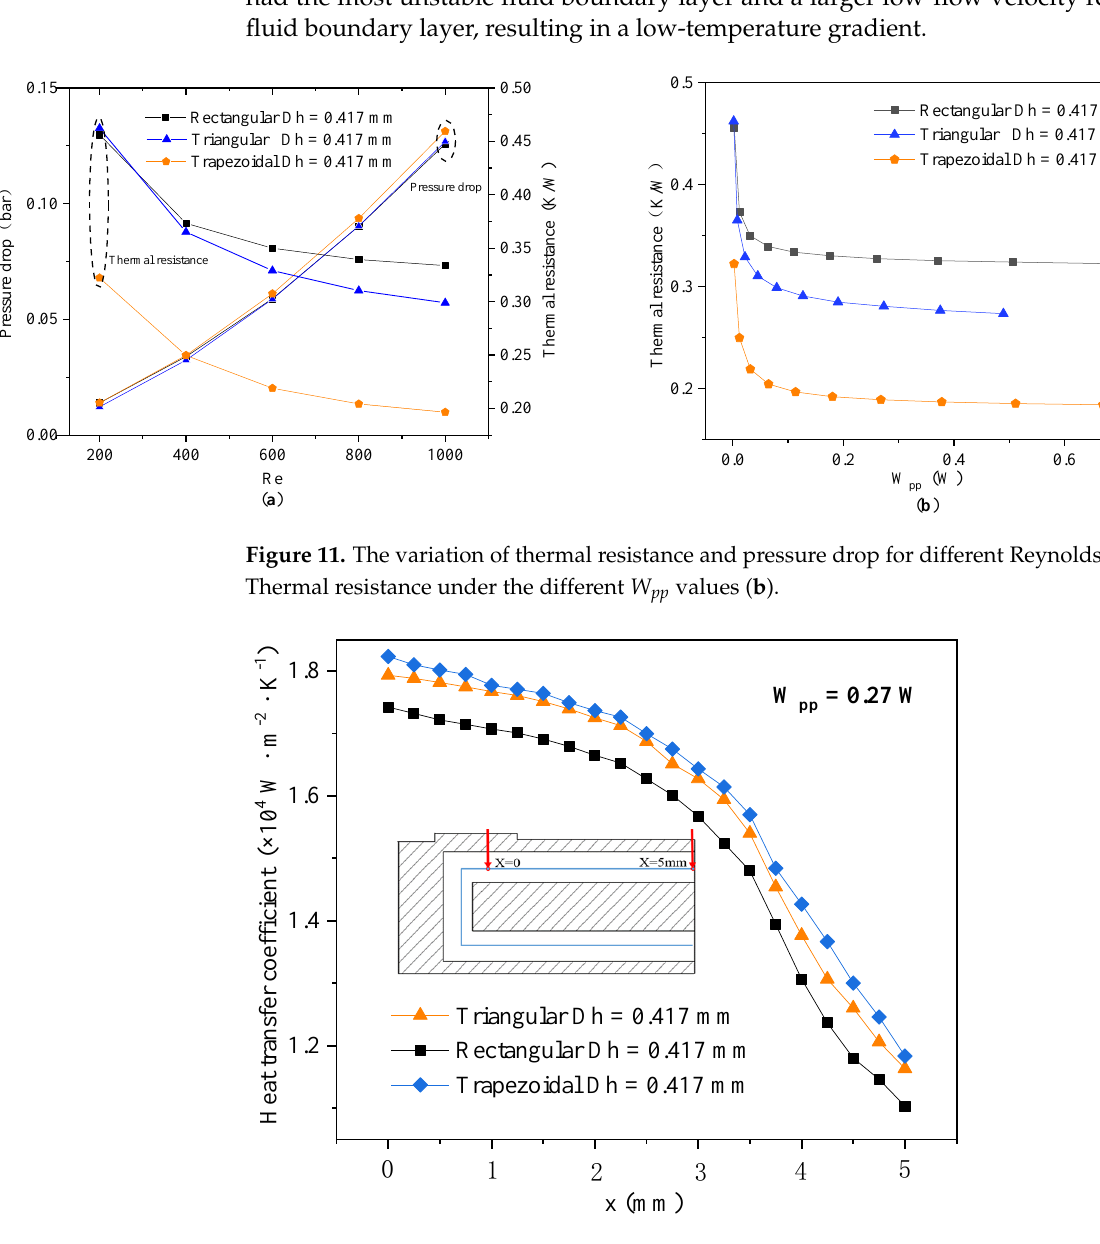
Figure 13. Temperature field along x – z of the top of microchannel heat sinks with different cross- section shapes ( D h = 0.417 mm, W pp = 0.27 W) ( a ). Temperature field and velocity flow diagram along x – z middle cross-sections of different microchannels ( D h = 0.417 mm, W pp = 0.27 W) ( b ). 4.4. The Effect of Channel Number on the Performance of Microchannel Heat Sinks The number of channels was also crucial for increasing the performance of an MCHS under the same porosity. The flow area was divided into N equal parts in the width direction with the same height, and the total porosity was kept constant to study the impact of N on the heat transfer performance of the sink. As shown in Figure 14a, when the N increased from 10 to 30, the thermal resistance clearly decreased with the same inlet flow ( Re ). The hydraulic diameter of a single channel was also significantly reduced, while the wet perimeter and the convective heat transfer area of the single mi- crochannel increased. In parallel, the total convective heat transfer surface of the MCHS increased along with an increasing number of channels, which significantly contributed to enhancing the heat transfer properties of the MCHS. However, the further increase in the value of N could not appreciably reducing the thermal resistance as N > 30, which was due to the microchannel walls also becoming